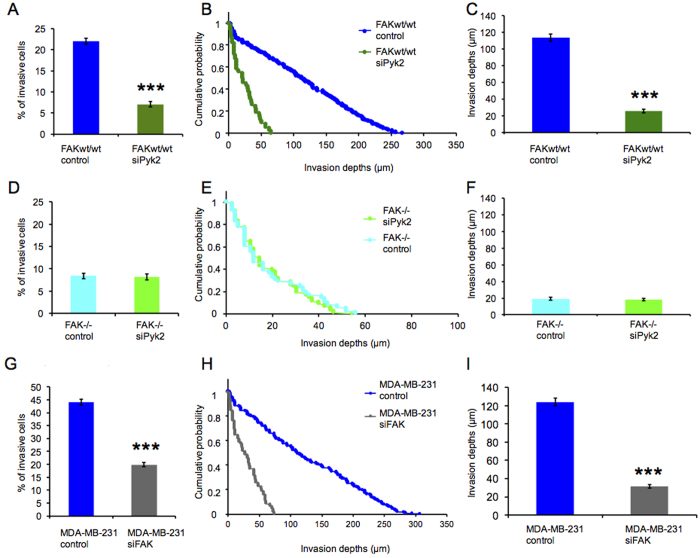
Reduction of Pyk2, in addition to FAK, can further reduce invasiveness of FAKwt/wt cells.(A) After siPyk2 silencing, which efficiently suppresses FAK and Pyk2 expression (Supplementary Fig. S1 and Table S1), the percentage (mean ± SD) of invasive FAKwt/wt cells treated with siPyk2 is significantly reduced compared to cells treated with unspecific control siRNA. (B) The invasion profile and (C) the average invasion depth of FAKwt/wt cells treated with siPyk2 are greatly reduced compared to control and also to siFAK treatment affecting FAK protein only (Fig. 1F–H). By contrast, siPyk2 was ineffective in FAK−/− cells and could not reduce significantly Pyk2 levels, at least compared to FAKwt/wt cells (Supplementary Fig. S1 and Table S1). Consistently, (D) the percentage (mean ± SD) of invasive FAK−/− cells, (E) the invasion profile and (F) the average invasion depth do not indicate any differences in FAK−/− cells treated with siPyk2 in relation to respective controls. (n = 3, p*** < 0.001). (G–I) Effect of FAK expression on cancer cell invasiveness. Human MDA-MB-231 breast cancer cells were transfected with human-specific siFAK and control siRNA (Supplementary Fig. S1 and Table S1) to analyze the consequences of FAK knock-down. The invasiveness of siFAK-treated breast cancer cells is significantly reduced, characterized by the decreased percentage (mean ± SD) of invasive cells (G), the invasion profile (H) and the decrease in average invasion depths (I). (n = 3, p*** < 0.001).